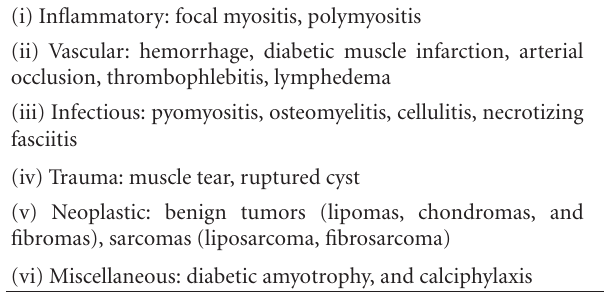
Table 1: Di ff erential diagnosis of focal extremity pain in patients with diabetes